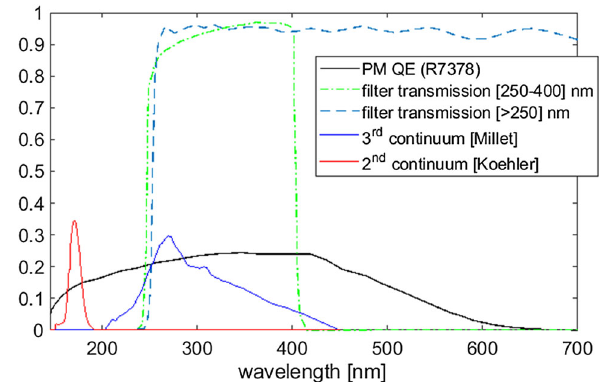
Fig. 2 Left: sketch of the experimental setup, indicating the main ele- ments and distances, as described in text. Right-top: arrangement of various PM+filter assemblies. Right-bottom: wire plane layout